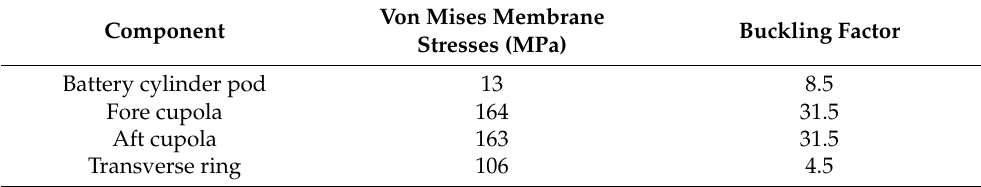
Table 3. Structural component